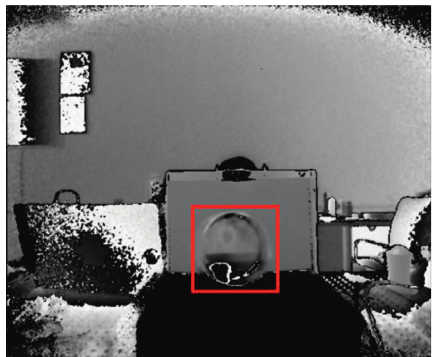
Figure 5: Examples of holes in the depth map. The object in the red box is transparent